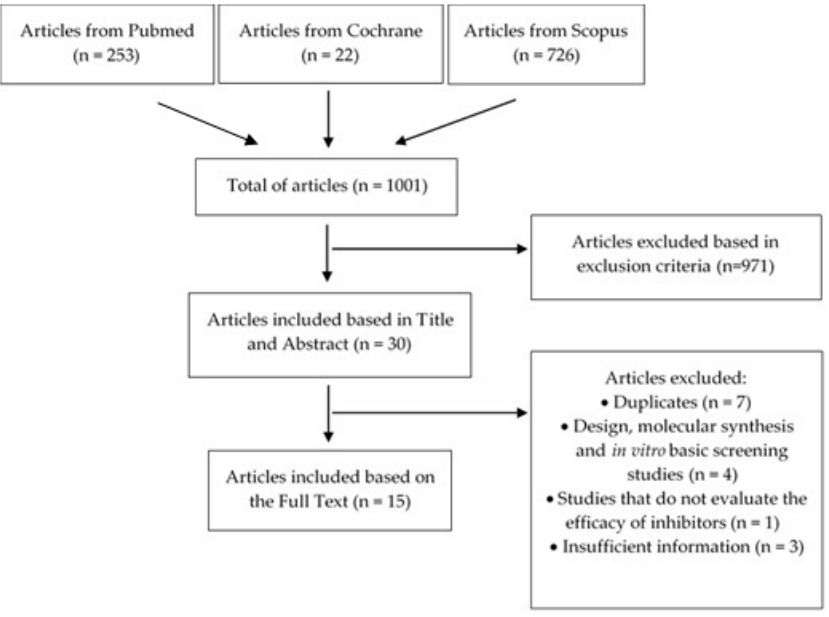
Figure 2. Flowchart regarding the article selection process.